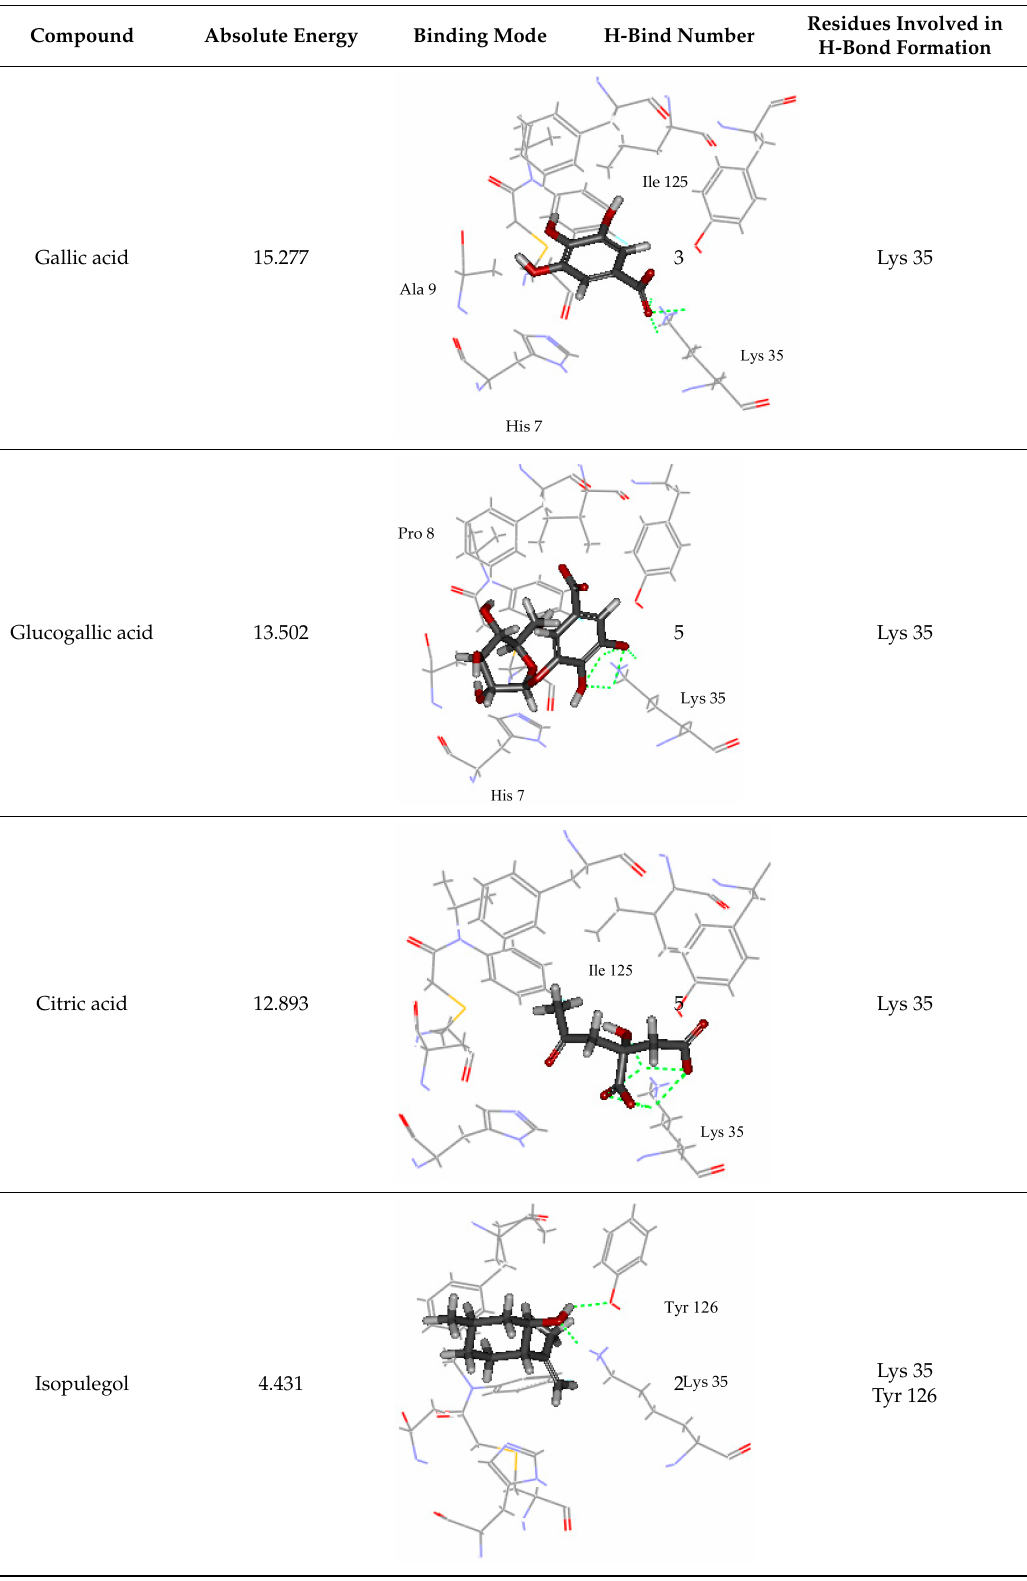
Table 4. Docking model of active